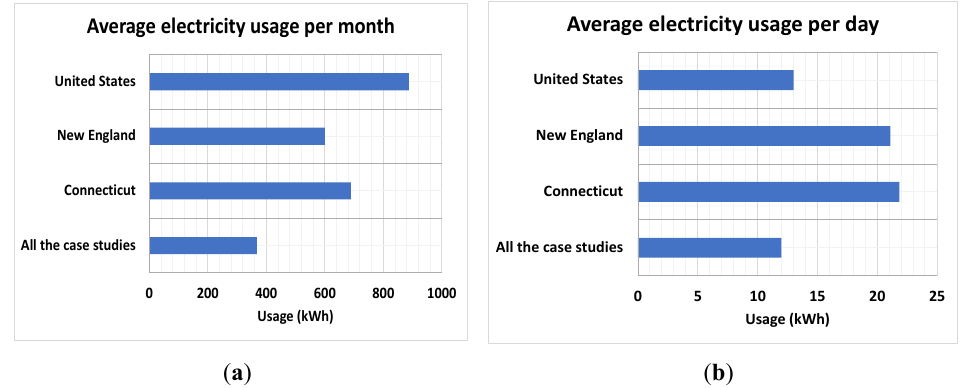
Figure 10. Comparative charts of the mean values of electricity usage per ( a ) month and ( b ) day.